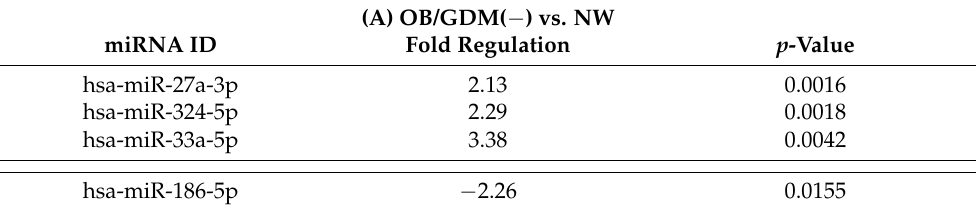
Table 2. Differentially expressed miRNAs in maternal